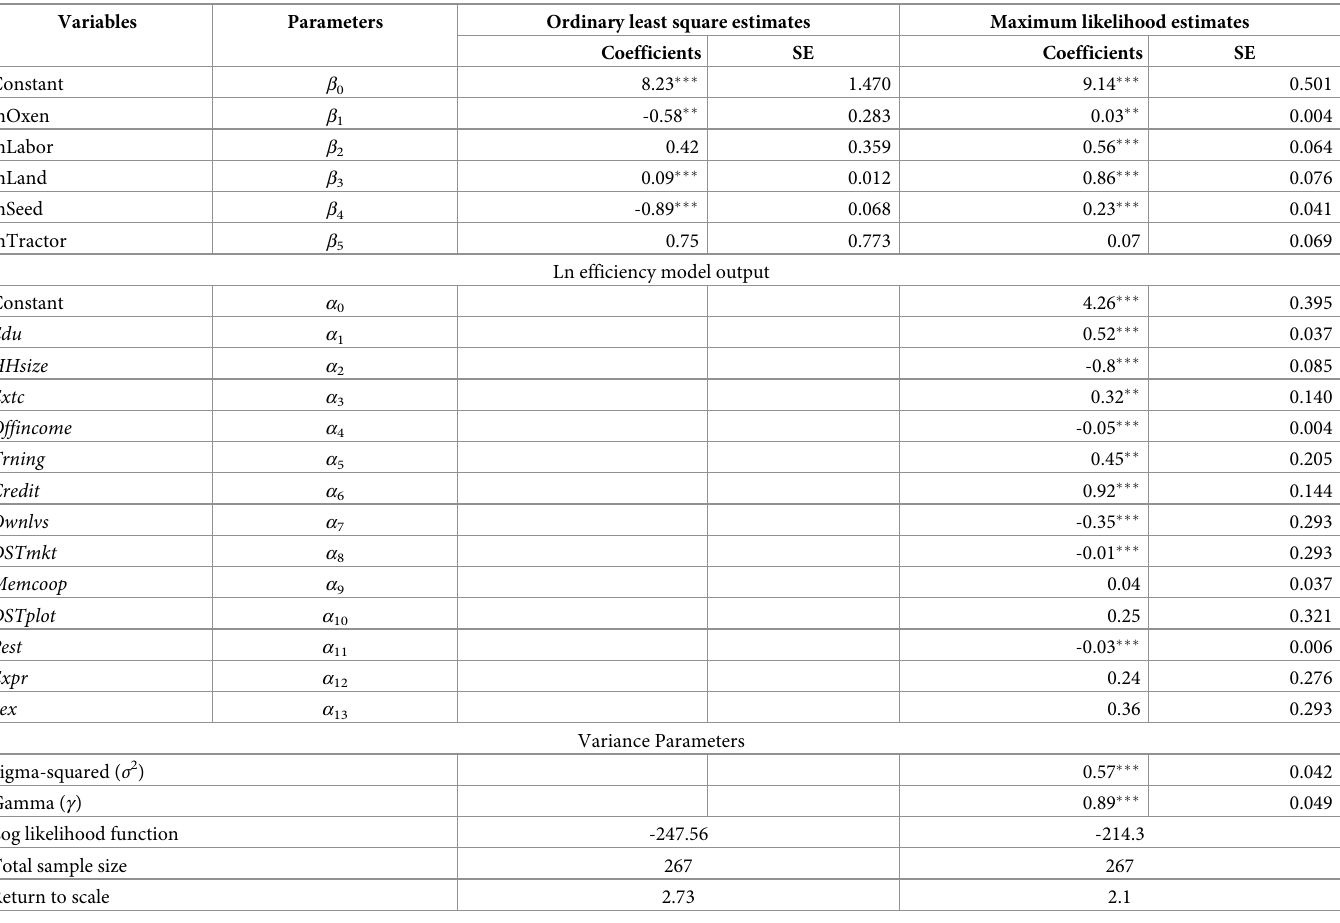
Table 5. OLS and maximum likelihood estimate for Cobb–Douglas production function for